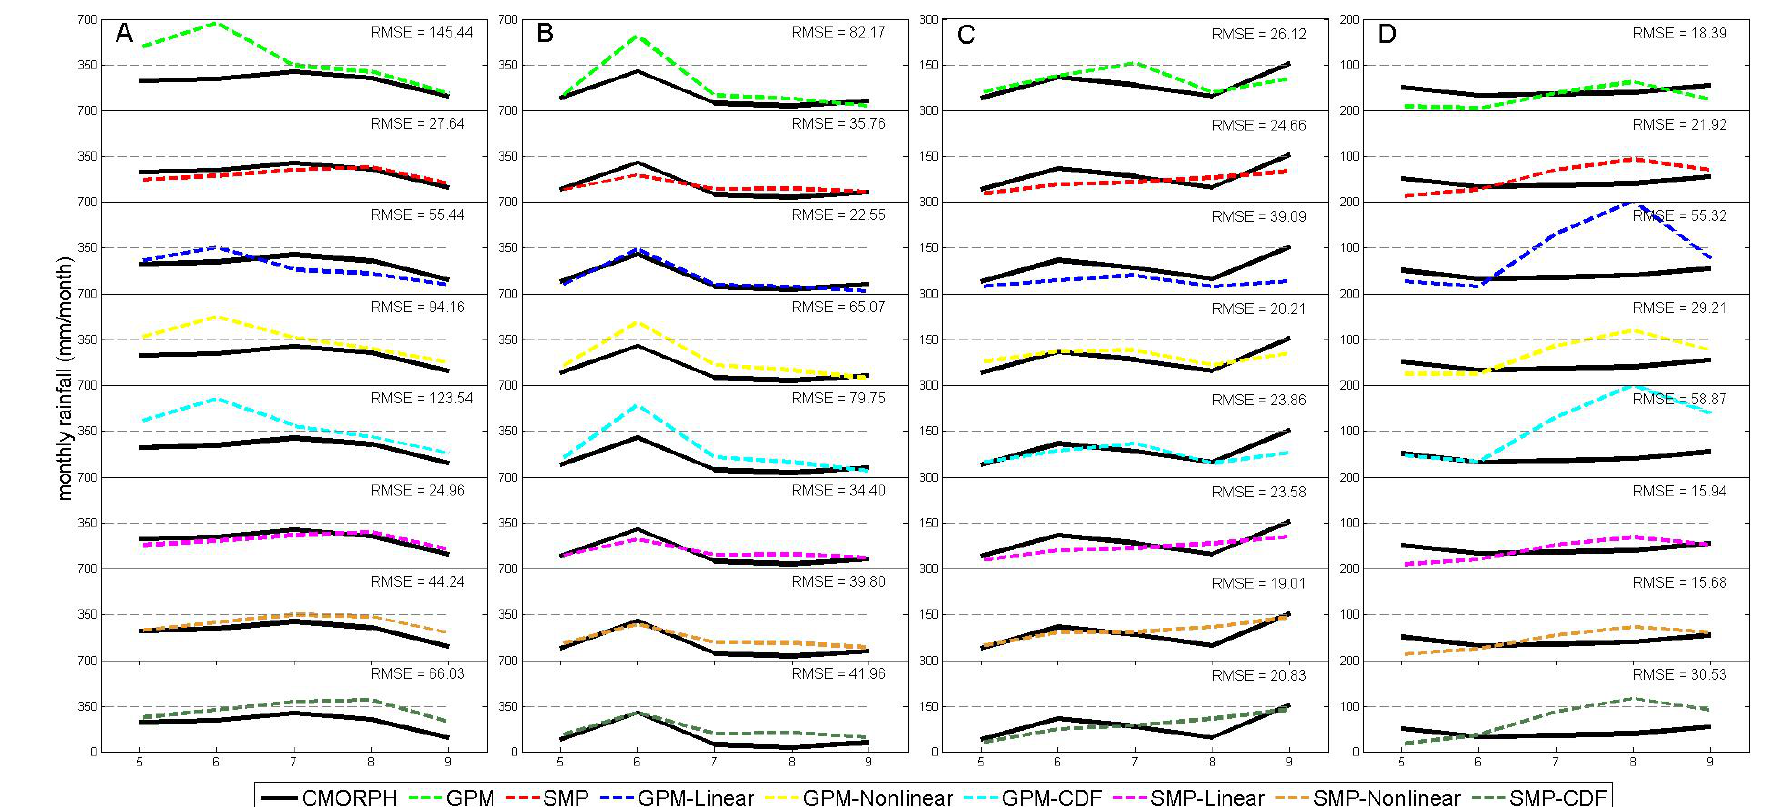
Figure 5. Time series of monthly rainfall in May to September of 2017 obtained from CMPA, GPM, and the seven corrected products (SMP, GPM-Linear, GPM-Nonlinear, GPM-CDF, SMP-Linear, SMP-Nonlinear, and SMP-CDF) for the four boxes A, B, C and D shown in Figure 1. RMSE: root-mean-square error in mm/month.